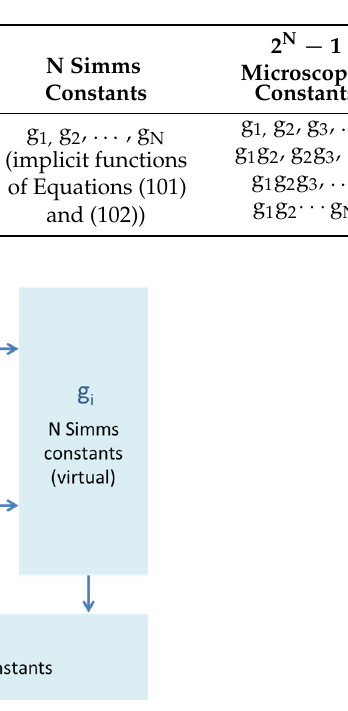
Figure 23. Interrelation between different types of equilibrium constants of a polyprotic acid H N A.